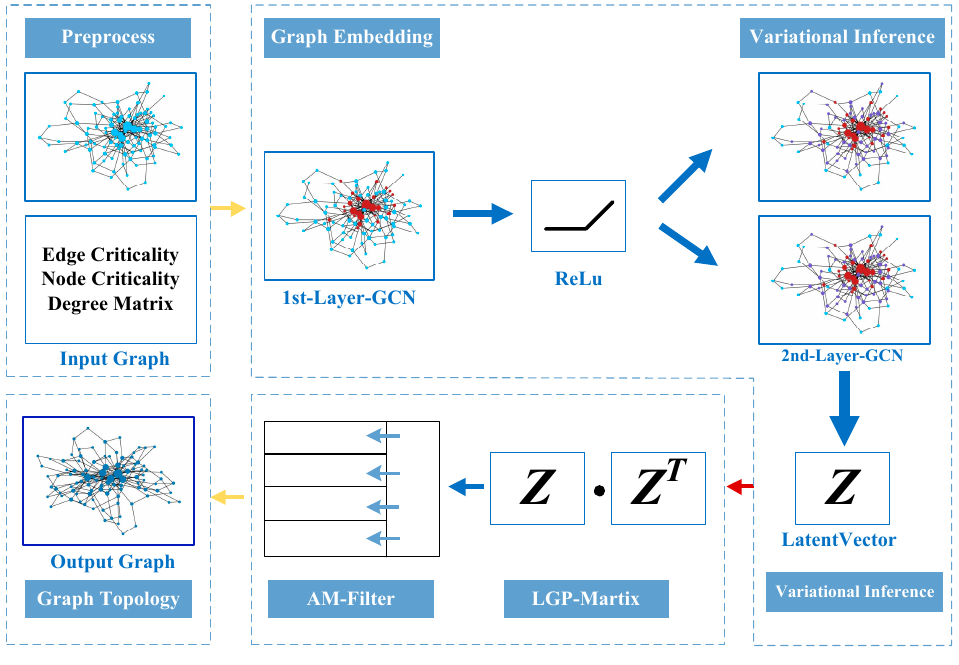
Figure 1. Main structure of the VGAE-AMF algorithm model. (Note that Z is the graph embedding vector of the input network and Z T is the transpose of Z ).